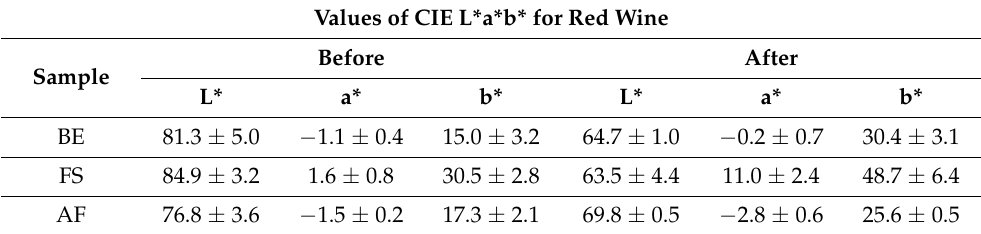
Table 4. Mean ± standard deviation values recorded for CIE L*a*b*, before and after immersing the specimens in the red wine